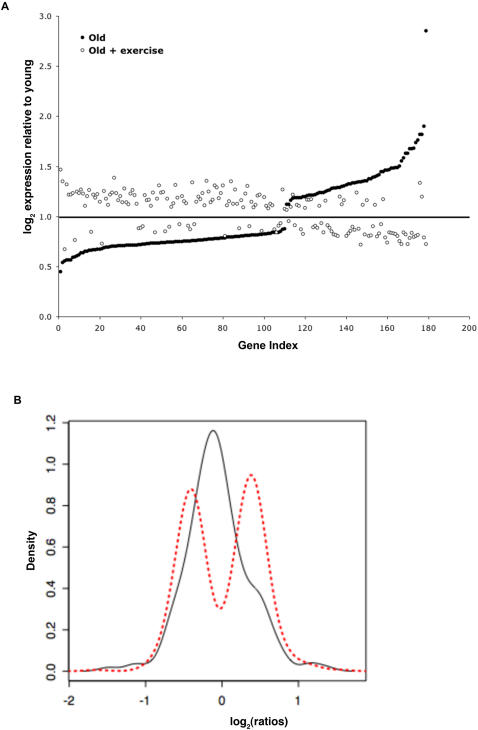
Gene expression changes associated with aging are reversed to youthful levels after 6 months of exercise training.Of the 596 genes associated with age in physiologically normal individuals, 179 of these were statistically significantly associated with a response to exercise at an FDR of 5%. a. Gene Index represents the 179 genes associated with age and exercise. The expression of these genes has been normalized relative to young values (young expression is represented by the dark line drawn across the graph at 1). Each genes average relative expression within the 14 older individuals can be seen relative to younger individuals. Genes that are downregulated with age show a marked reversal to youthful levels with exercise, and genes that are upregulated with age also show the same trend to return to youthful levels in association with exercise. b. Permutation testing of genes associated with exercise and age, to determine statistically significant reversals with exercise. The x axis (log2) represents the ratio of older subjects post-exercise gene expression compared to young individuals, with 0 being equivalent to “young” gene expression. This resulted in a p-value of <0.02. The conclusion is that the log2 ratios are much closer to 0 (expression is the same in old-exercise and young) than one would expect by chance (random draw of the 596 genes related to age).